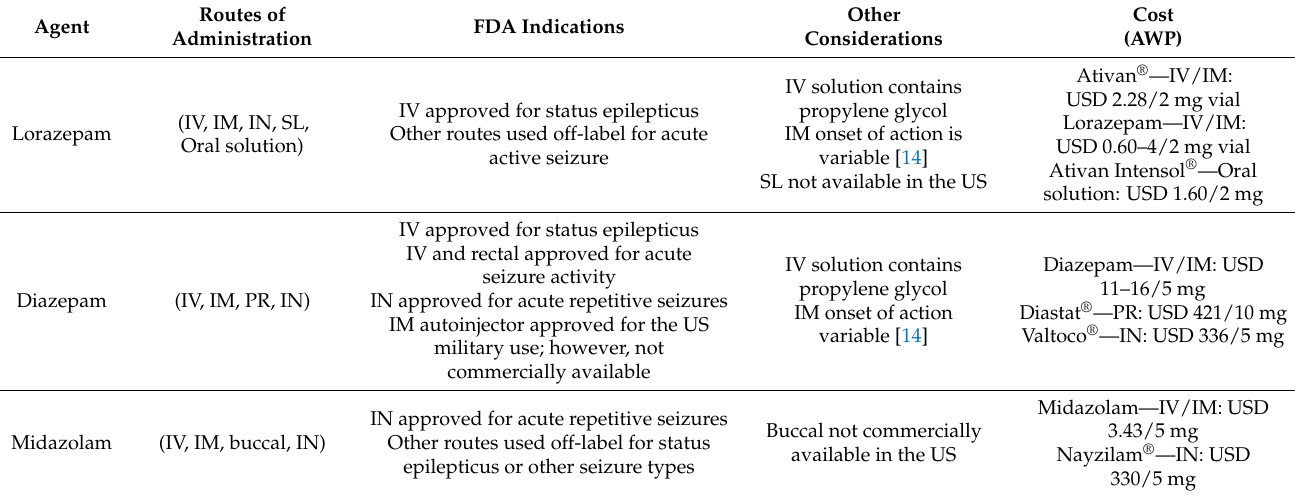
Table 1. Benzodiazepine products, routes, FDA indications, and cost